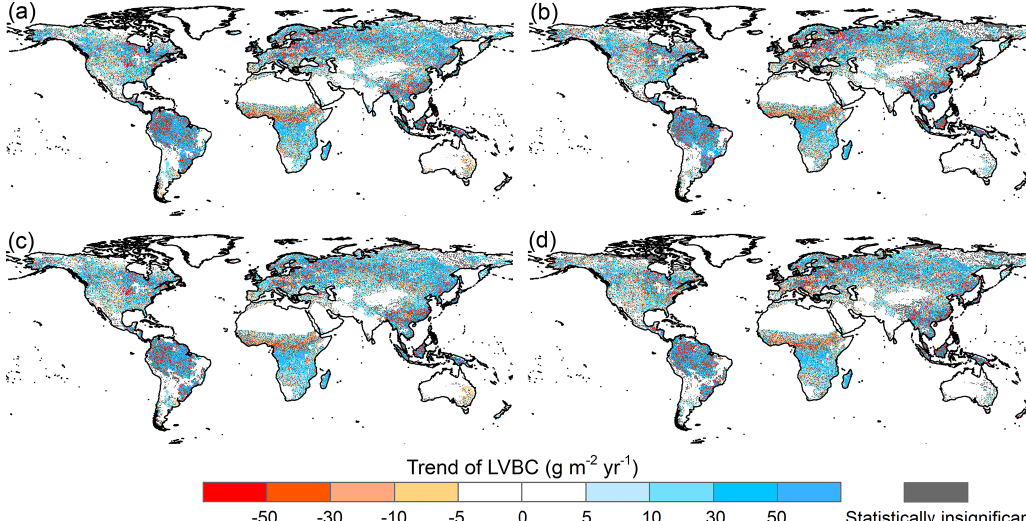
Figure A2. Potential LVBC trend maps during the period of 1916 to 2015 under different factorial simulations. (a) CO 2 driving facto- rial simulation (S2), (b) CO 2 + precipitation driving factorial simulation (S3), (c) CO 2 + temperature driving factorial simulation (S4), and (d) CO 2 + radiation driving factorial simulation (S5). Positive values indicate increasing trends in the ratio, and vice versa. All results from the Mann–Kendall and Sen slope statistical tests correspond to the 95% confidence interval.